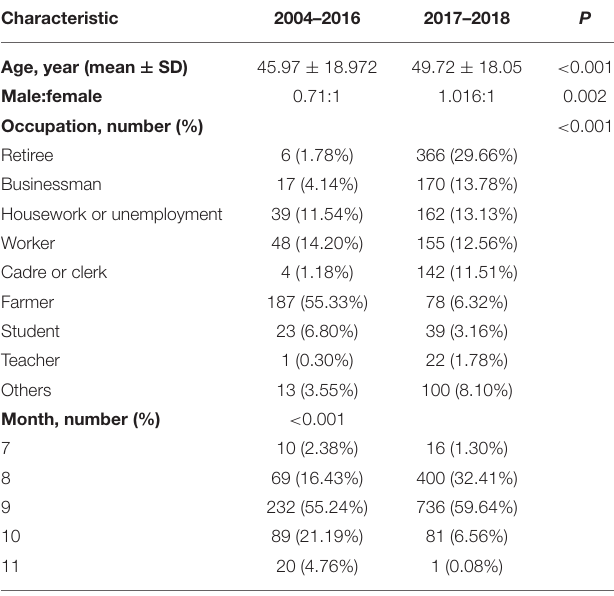
TABLE 1 | Characteristics of indigenous dengue cases in Zhejiang Province from 2004 to 2018.